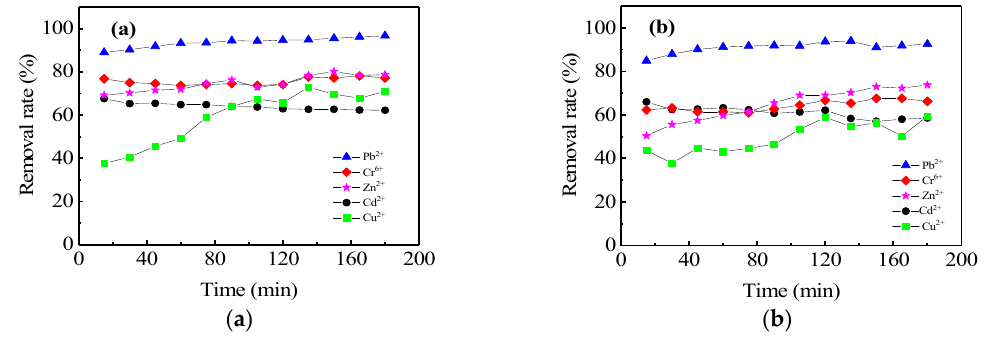
Figure 8. Effect of simulated stormwater infiltration pool on heavy metal removal. ( a ) pool 1 (with the PPG-nZVI bead filter layer); ( b ) pool 2 (without the PPG-nZVI bead filter layer).